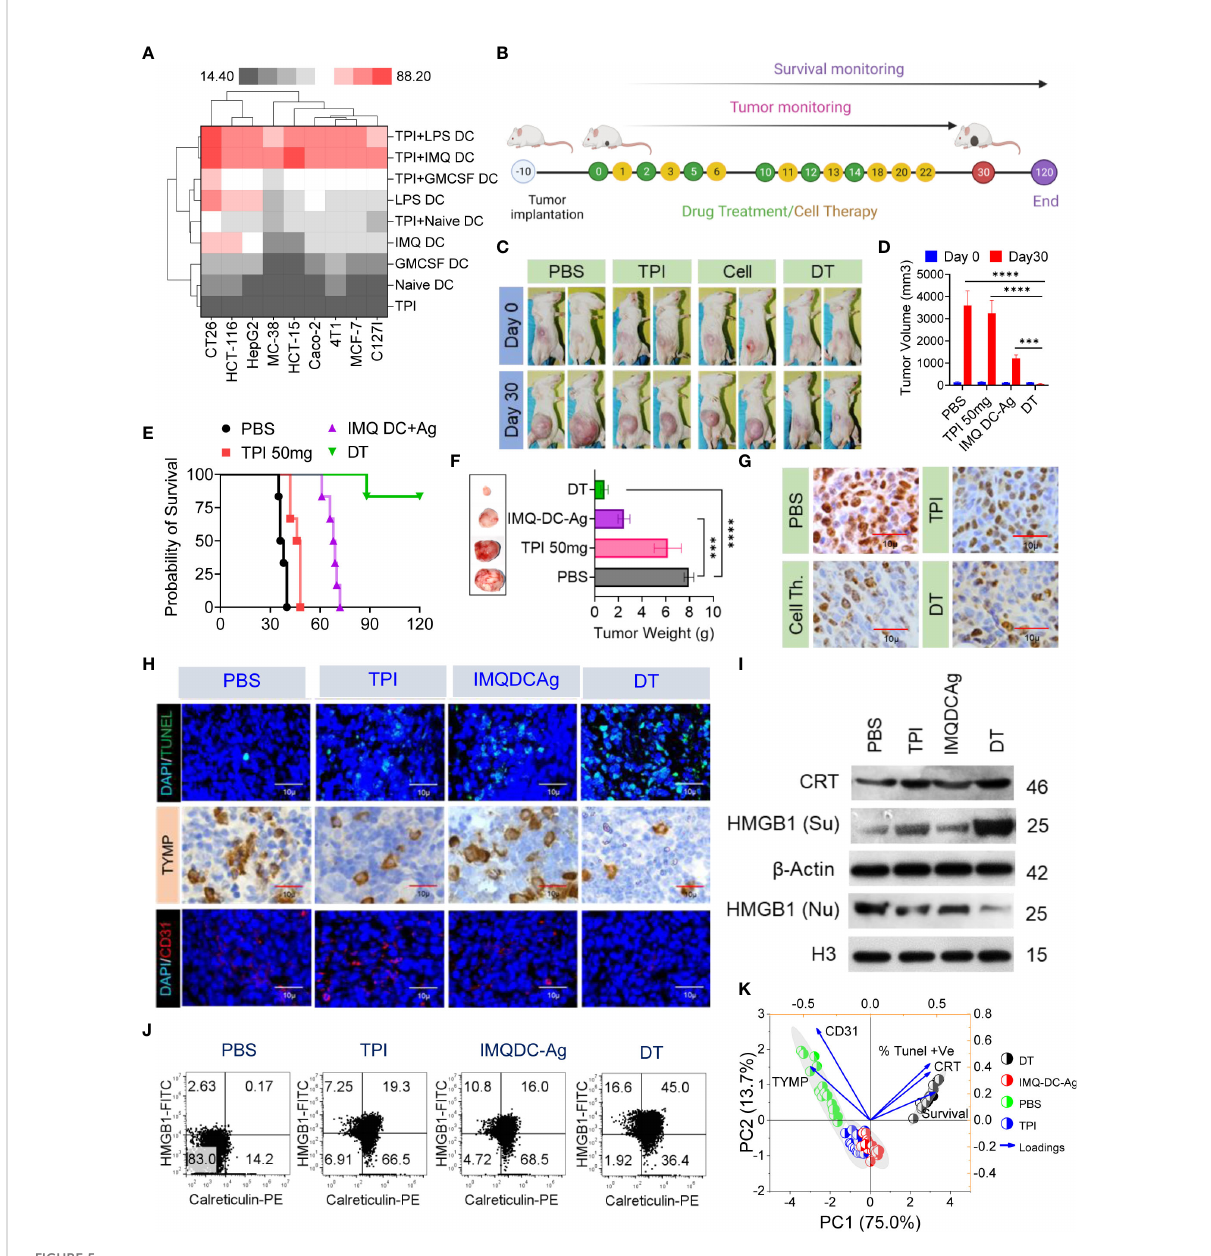
FIGURE 5 Extended tumor-free survival and enhanced antitumor immunity against CRC in mice treated with tipiracil + imiquimod-activated DCs are accompanied by higher levels of ICD. (A) Heatmap showing the enhancement of growth inhibition of TPI-treated murine (CT-26, MC38, 4T1, C127i) and human (HCT116, HCT-15, HepG2, Caco2, MCF-7) cells by GMCSF (1000 U/ml) and imiquimod (200 pg/ml)-activated murine BMDCs and human DCs. LPS (10 m g/ml) was used as a positive control. (B) Experimental schedule; treatments as in (A) every alternate day 6 times with two booster doses of cell therapy. (C) Images of the animals in the indicated groups. (D) The averaged tumor growth diagram at day 0 vs day 30 in the indicated groups. (E) Kaplan – Meier analysis of the mice; n = 6 mice. Median survival for PBS (37 days), 50 mg kg - 1 bw/day (47 days), IMQDC+Ag (70 days), and dual therapy (DT) (unde fi ned), p <0.0001]. (F) The average tumor weight of each group and images of the tumors dissected on day 30; mean ± SD, n = 3 mice. (G) Representative tumor tissue sections from three mice showing immunostaining for Ki-67. (H) TUNEL staining of the tumor sections dissected on day 30 (top); green: TUNEL; blue: DAPI; IHC analysis of TYMP (middle), and immuno fl uorescence analysis of CD31 (bottom) in CRC tumors of the indicated groups, scale bars: 50 m m; the experiment was repeated independently three times to con fi rm the results. (I) Western blot analysis of CRT and HMGB1 expression in tumor tissue and its fold increase or decrease compared to the untreated control. b -Actin and H3, loading controls for the cytoplasmic and nuclear fractions, respectively. (J) Dot plot represents fl ow cytometric analysis of CRT-HMGB1-positive cells (gated on propidium iodide-negative cells (PI)). (K) Principal component analysis to predict the biomarker correlated with median survival among treatment groups. Unless otherwise noted, the data are presented as independent biological triplicates. In vivo studies were repeated independently fi ve times to con fi rm the results. and ***p <